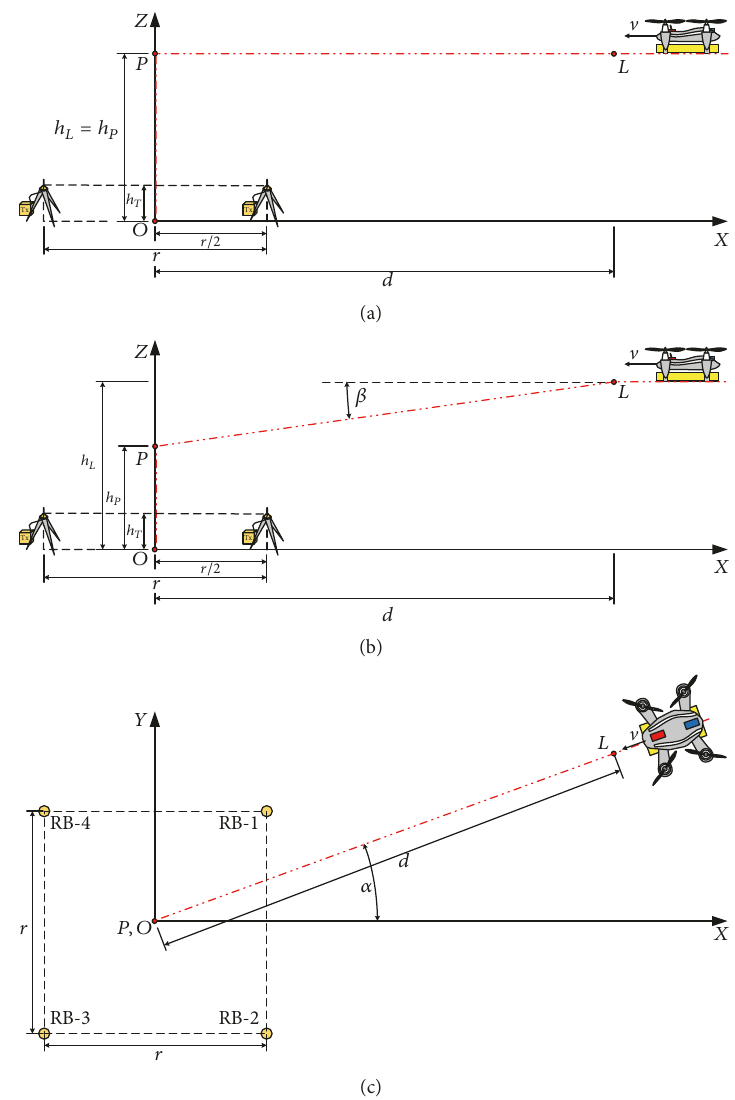
Figure 4: Direction of VTOL arrival to landing site with respect to the location of